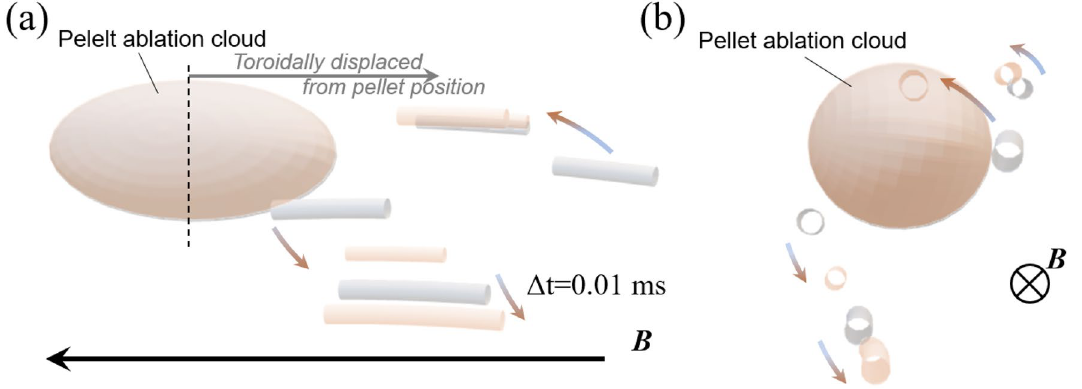
Figure 5. ( a ) Reconstructed fluctuation structure on the 3D model surrounding the pellet ablation cloud from the line of sight approximately in the perpendicular and ( b ) parallel directions to the magnetic field. Different color indicates fluctuation structure at different timing with the time interval of 0.01 ms. Fluctuations are located at the positions toroidally displaced from the pellet and rotate across the magnetic field around the pellet axis. The figures were drawn by